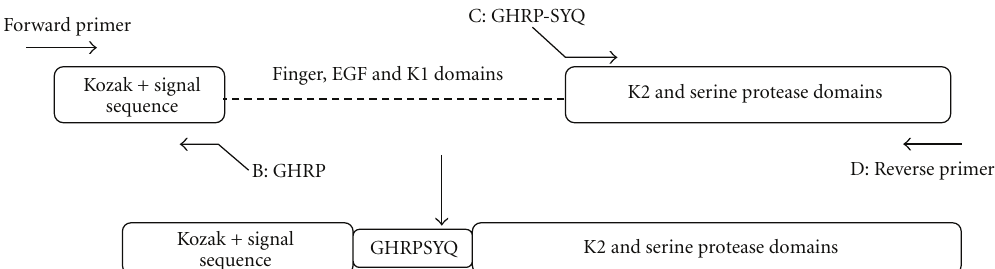
Figure 1: Schematic overview of primer designed for SOEing PCR